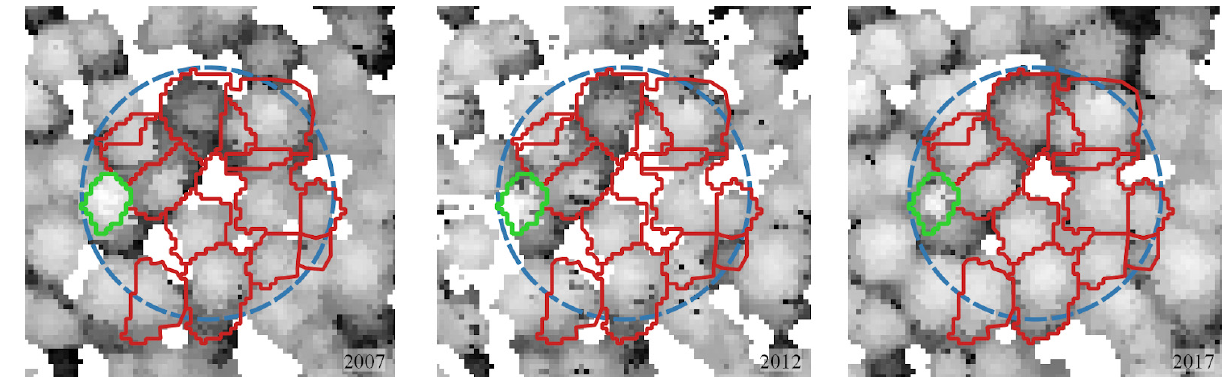
Figure 10. Example of a circular sample plot (blue, dashed outline) over time. We observe here a gradual death of a tree (green outline) and consequent reduction in the extent of its canopy area. Other Scot Pine trees (red outline) were not affected by this process.